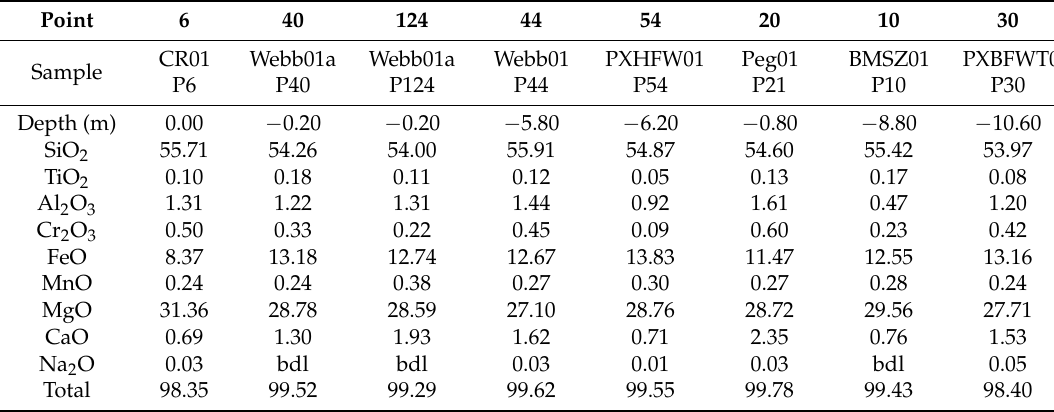
Table 3. Representative orthopyroxene analyses in wt